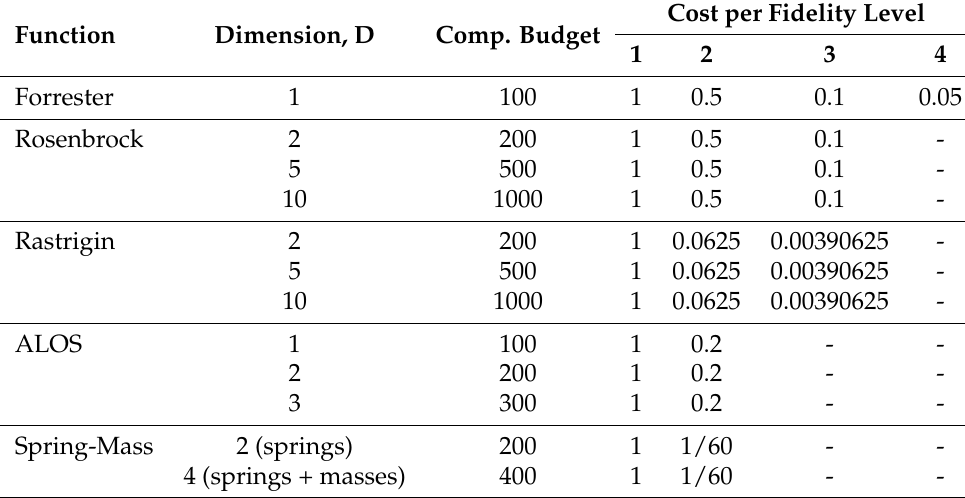
Table 2. Summary of employed benchmark problems.